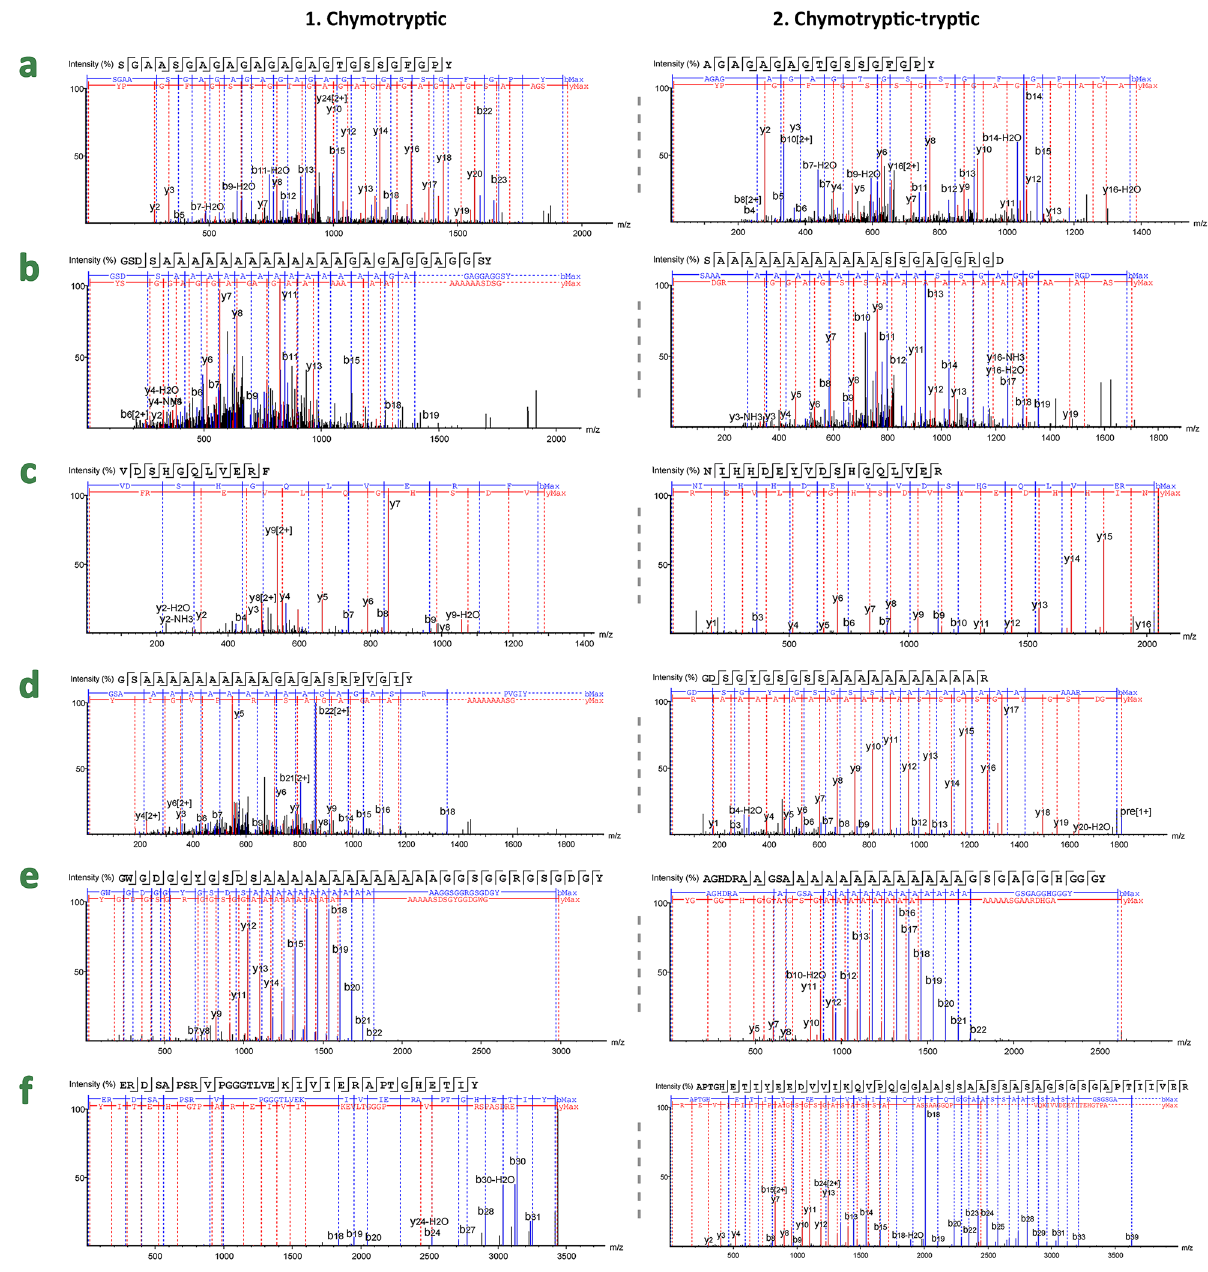
Figure 4. MS/MS spectra from the chymotryptic (column 1) and chymotryptic-tryptic (column 2) unique peptides with the highest probability scores from each sample. Sequences marked in red indicate species- specific sequences, and those marked in blue indicate genera-specific sequences. (a) B. mori : (1) SGAASGAG AGA GAG AGT GSSGFGPY ( m/z = 899.90, z = 2, −10lgP = 37.21); (2) AGA GAG AGTGSSGFGPY ( m/z = 692.81, z = 2, −10lgP = 42.48); (b) A. pernyi : (1) GSDSA 13 GAG AGG AGGSY ( m/z = 698.65, z = 3, −10lgP = 49.23); (2)